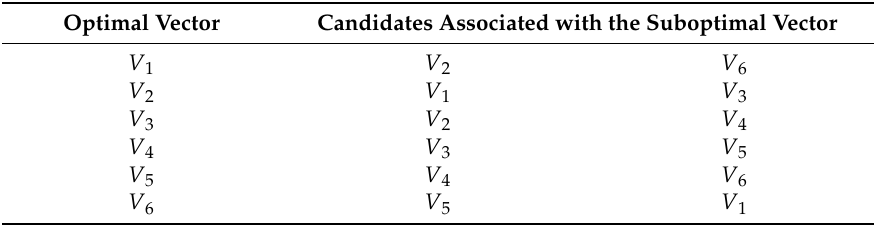
Table 1. Optimal vector and corresponding candidates associated with the suboptimal vector.